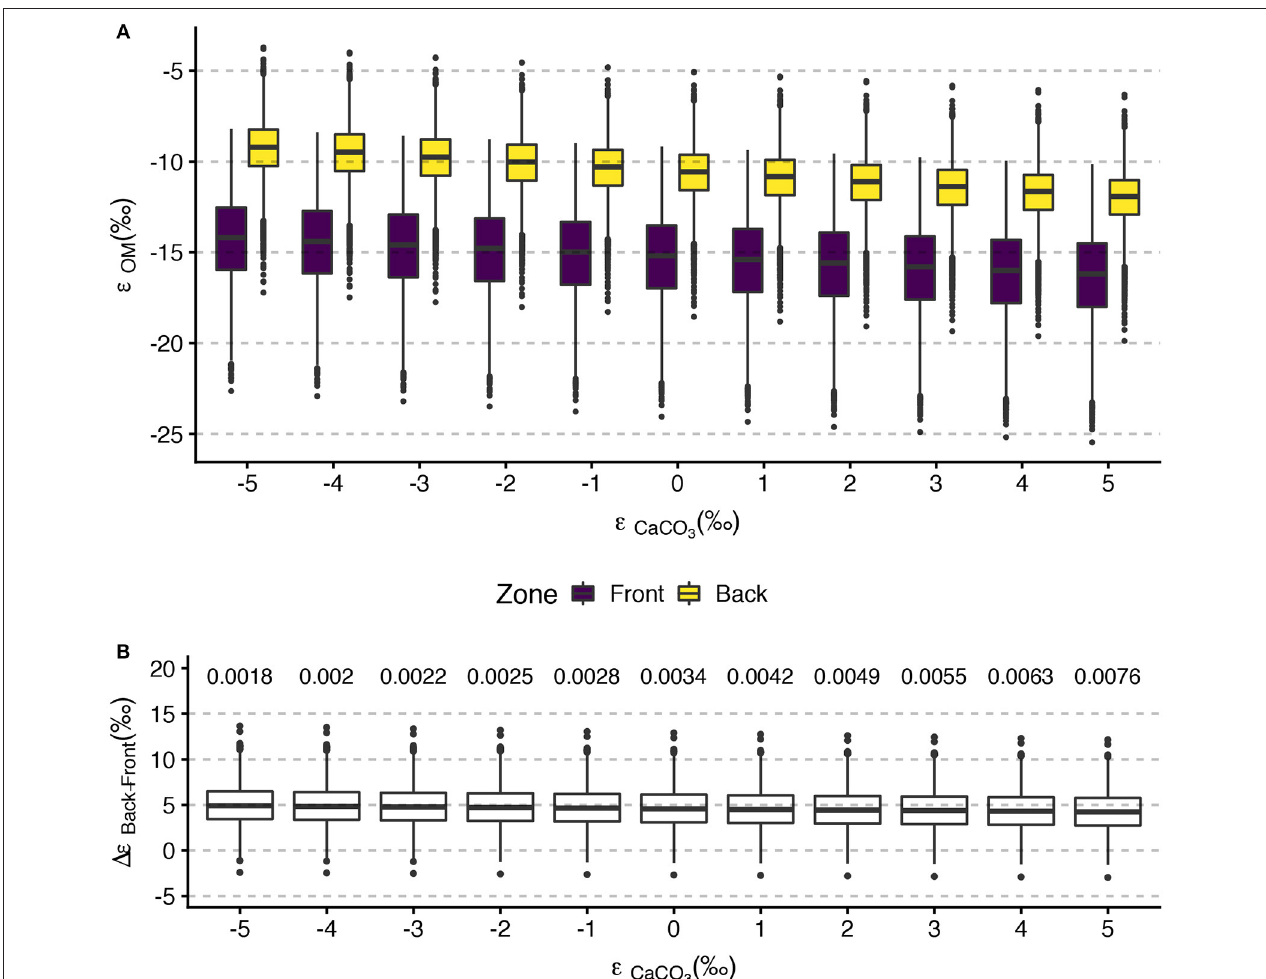
values and (B) 1ǫ OM between the back zone and front 3 and are offset for clarity. The numerical values above 1ǫ OM display the proportion of bootstrap 3